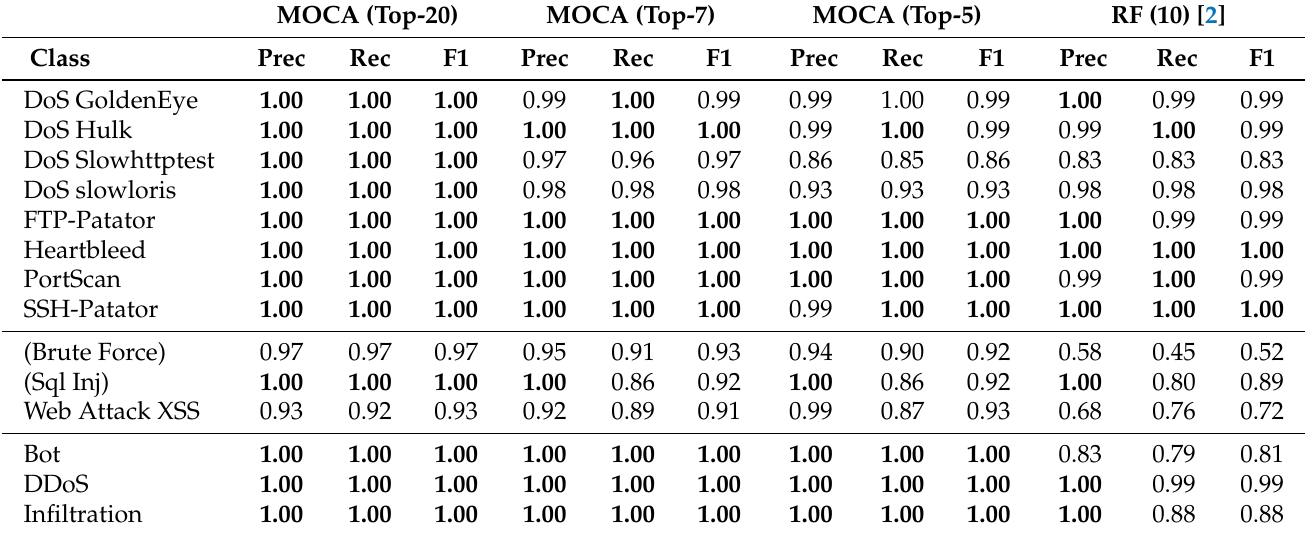
Table 2. Comparison of results of MOCA vs. previous work [2] based on CICIDS2017 dataset. MOCA